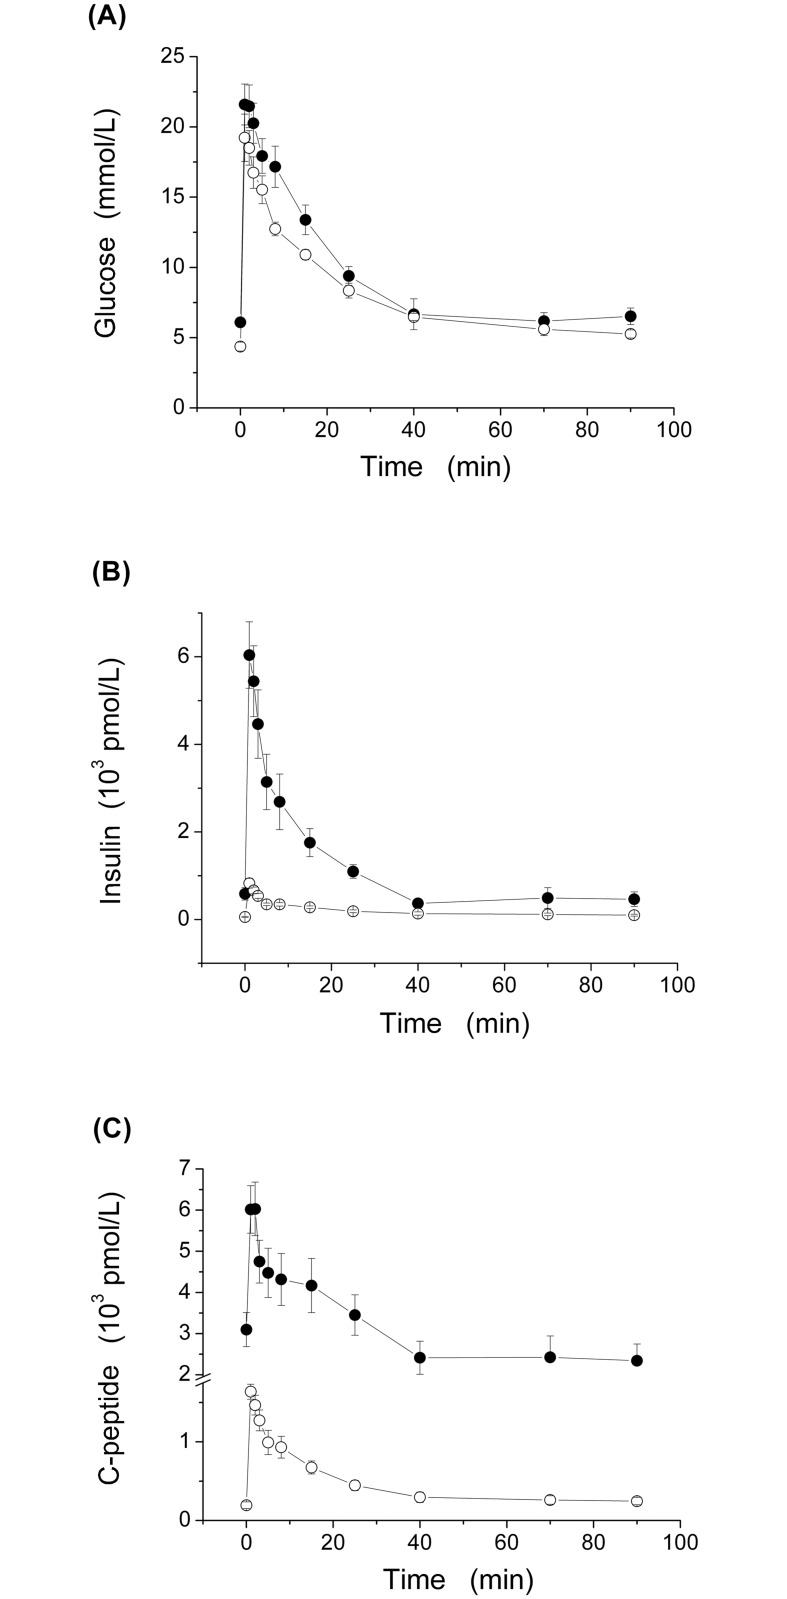
Time course of plasma glucose (G(t), panel A) insulin (I(t), panel B) and C-peptide (CP(t), panel C) concentrations during 90-min IVGTT in our ZFR group (n = 7, closed circles) and ZLR group (n = 7, open circles).Values are mean ± SE.